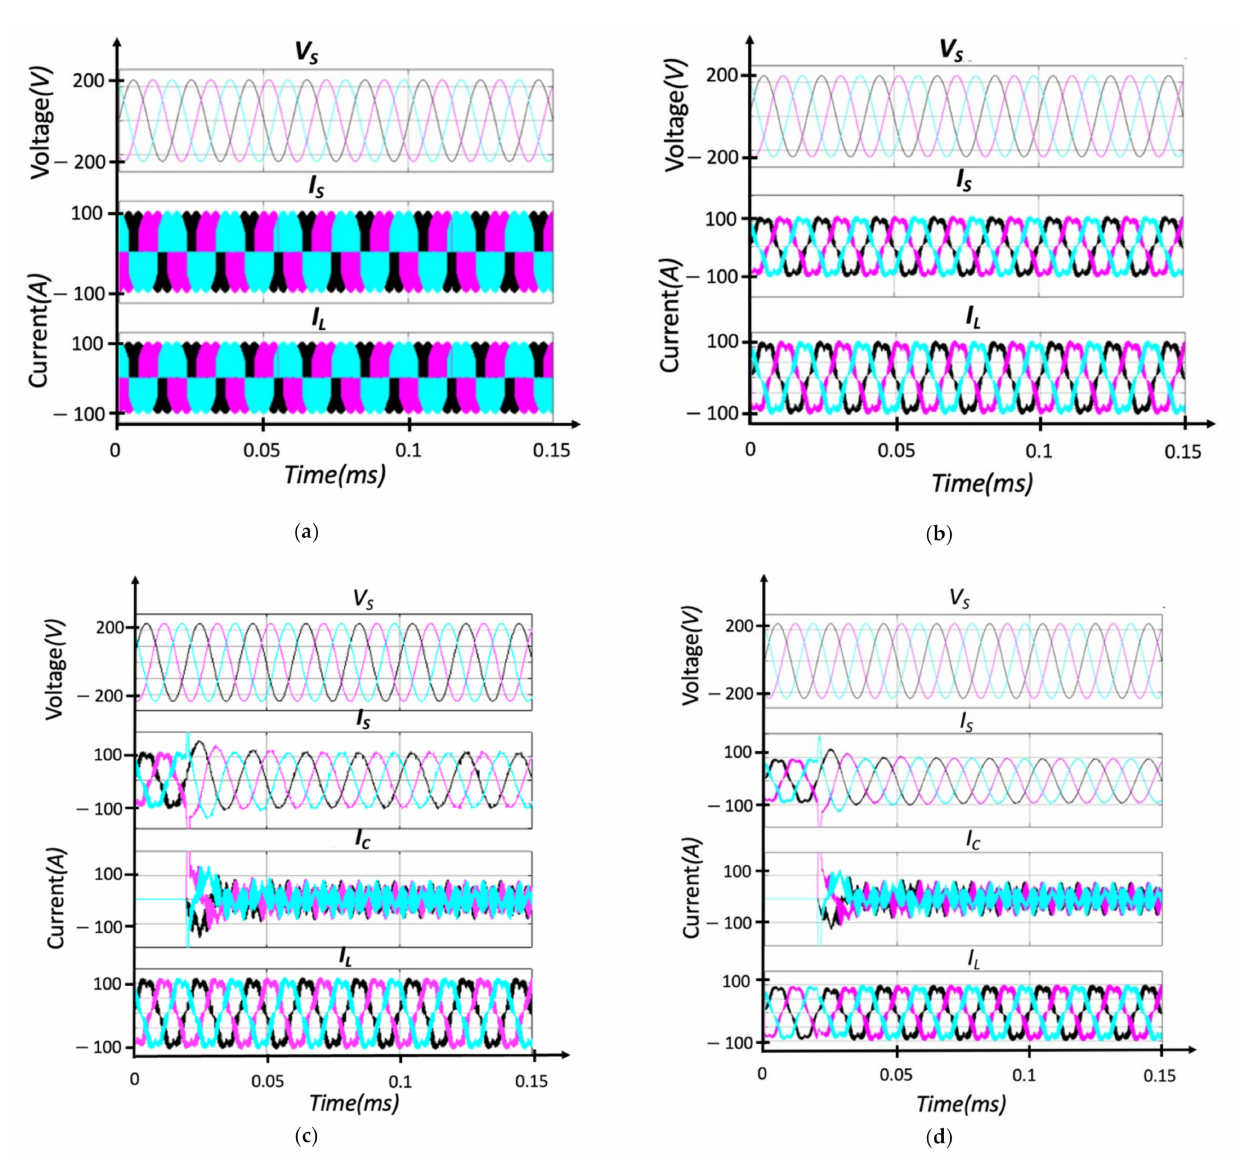
Figure 11. Setup with: ( a ) no filter; ( b ) passive R-L-C filter only; ( c ) HAPF with PI-controlled DC voltage; ( d ) HAPF with FIS-controlled DC